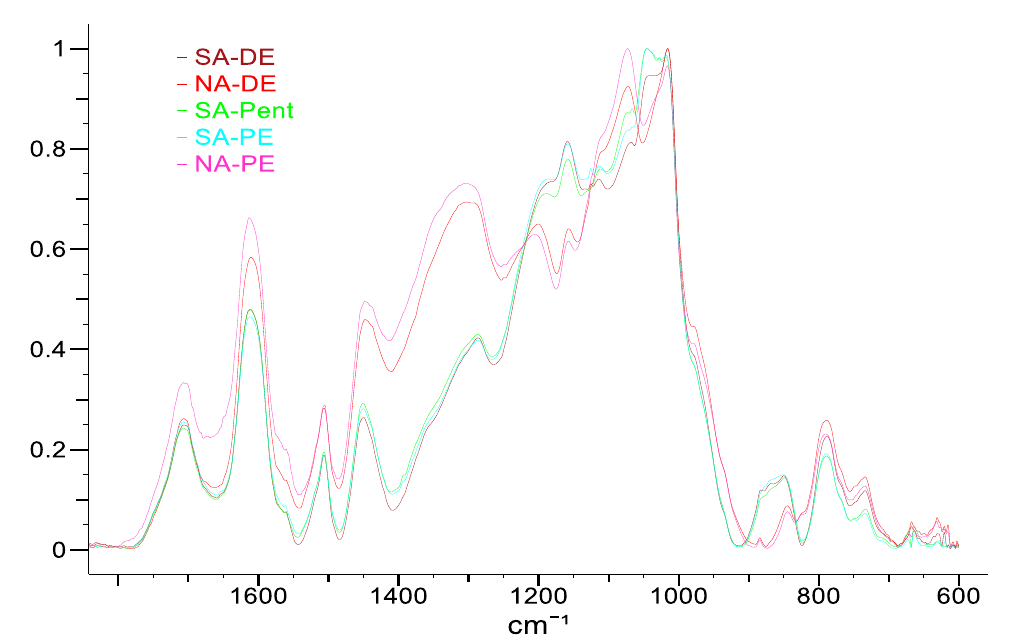
Figure 3. Attenuated Total Reflectance Fourier-Transform Infrared (ATR FT-IR) spectra of the five tannin-based foams between 1800 and 600 cm − 1 .